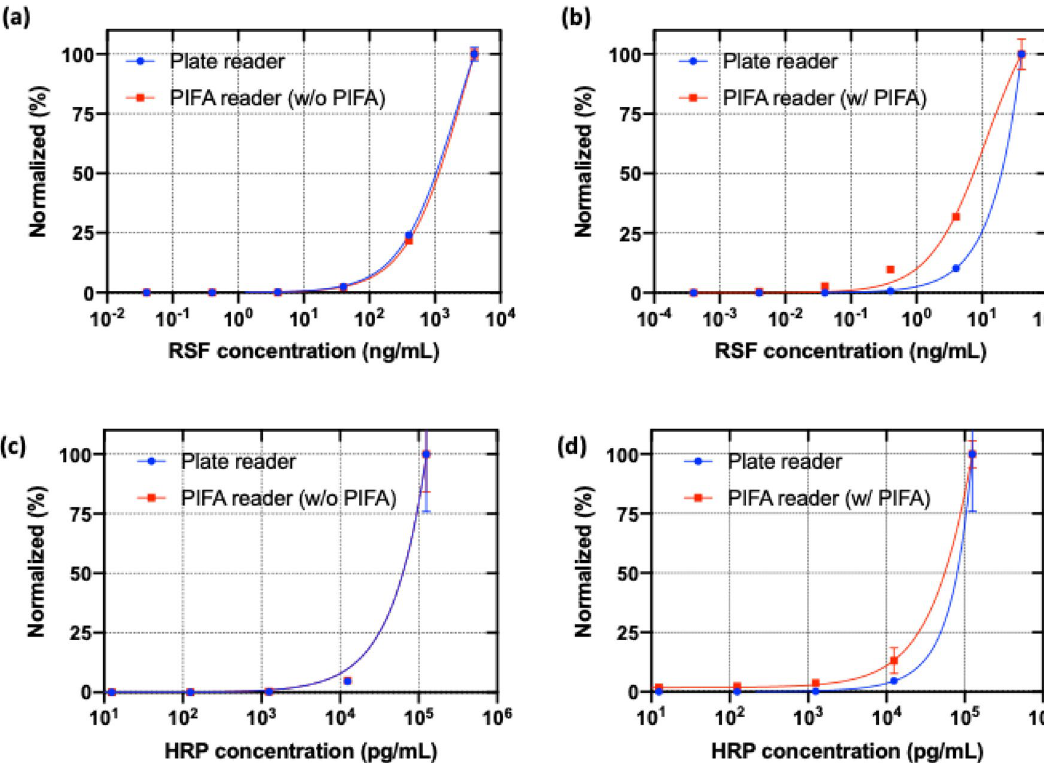
Figure 5. Normalized measurement of PIFA assay and plate reader when concentrations of resorufin ( a , b ) and HRP ( c , d ) were changed: the measurement output of plate reader is fluorescence intensity and that of PIFA is AI ratio. The limit of detection of two methods were compared after normalization. ( a , c ) The normalized fluorescence intensity of resorufin measured by plate reader and PIFA reader with no photooxidation ( b , d ) the normalized measurement of plate reader fluorescence and PIFA AI.